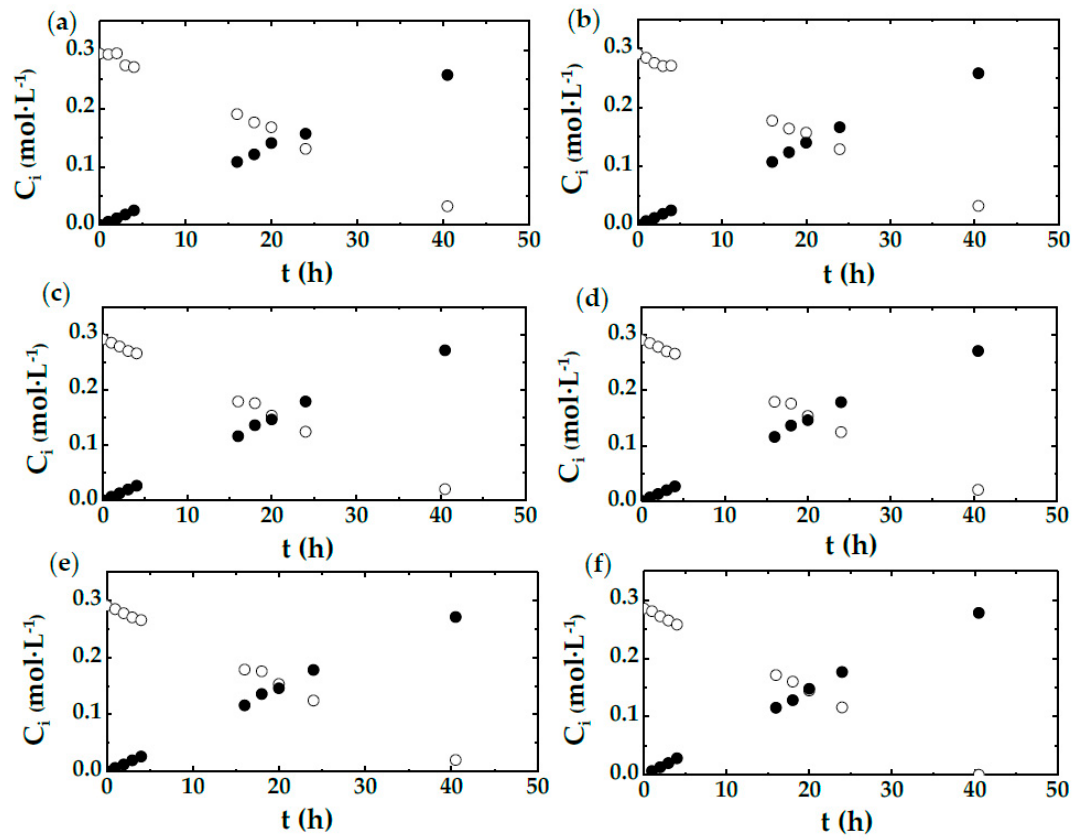
Figure 1. Experimental results. 1,3-dihydroxyacetone (DHA) ( (cid:8) ) and glycerol (